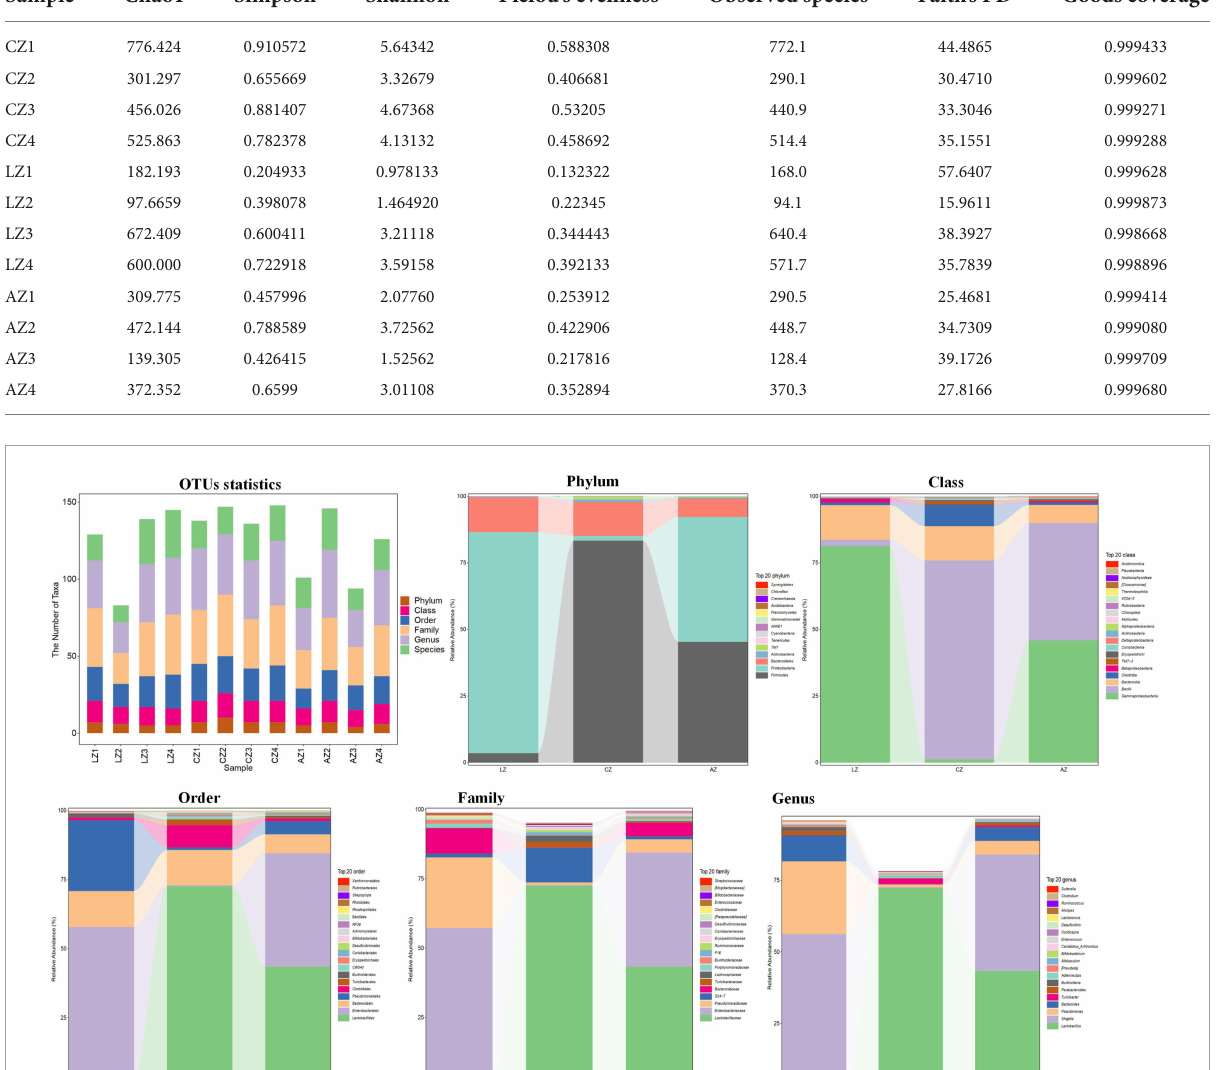
TABLE 3 Statistical analysis of alpha-diversity index.